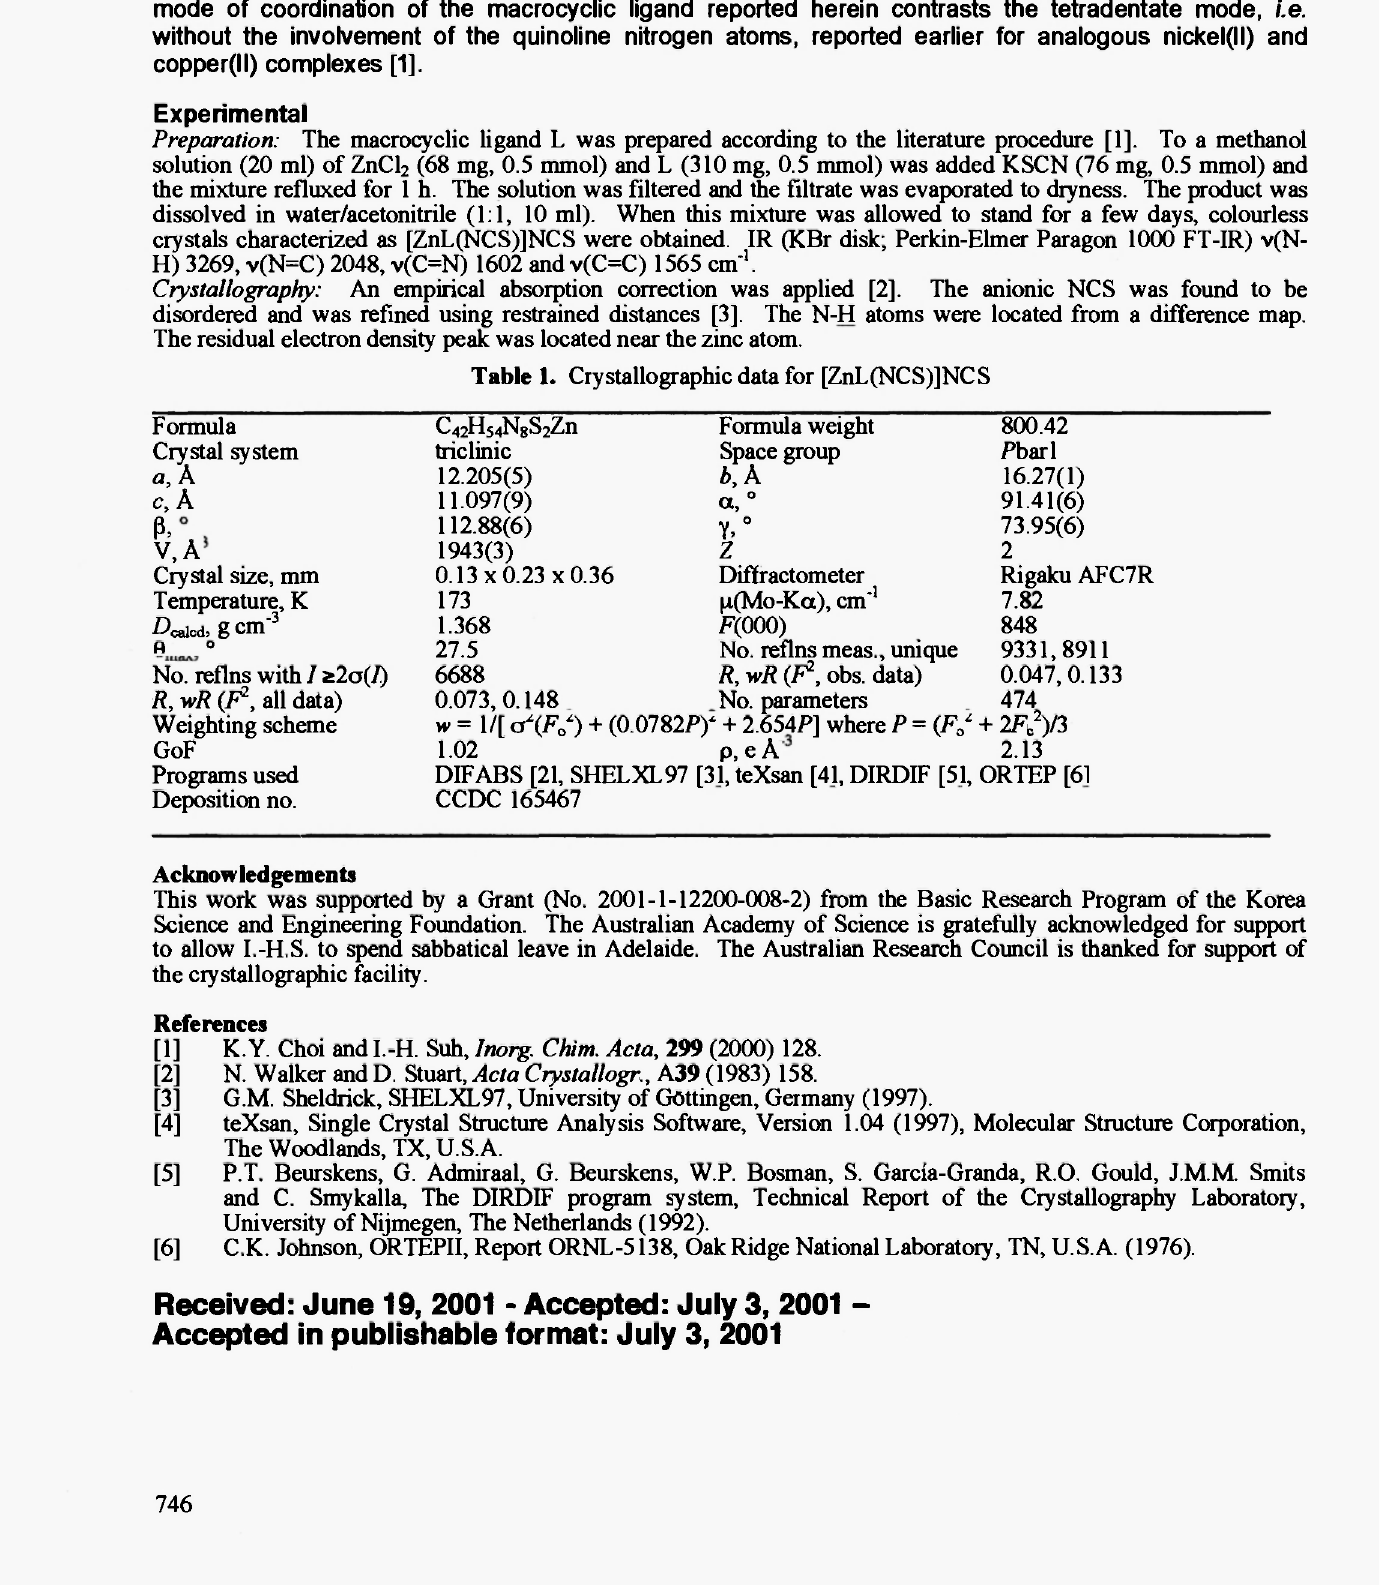
Table 1. Crystallographic data for